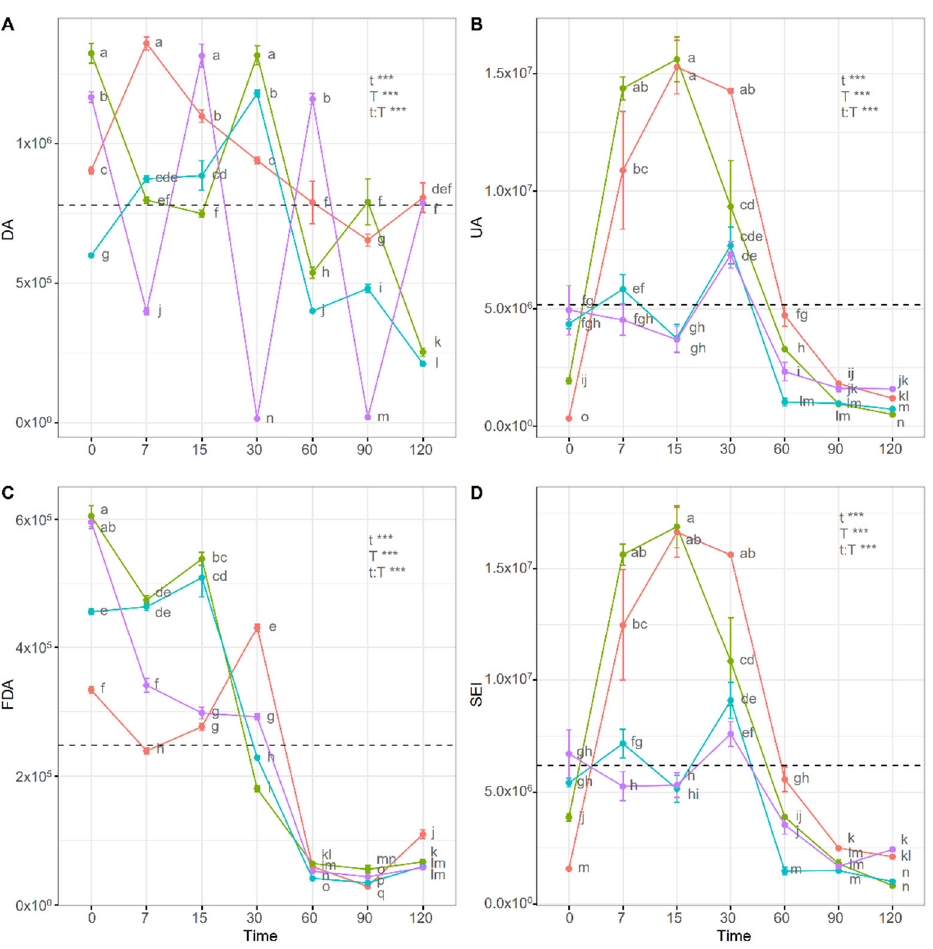
Figure 2. Two-way ANOVA of enzyme indicators of composting systems. Different letters indicate significant differences according to the two-way ANOVA with subsequent Tukey’s test for means at a significance level p ≤ 0.05. Vertical bars represent the standard deviation ( n = 5). ( A ) DA, dehydrogenase activity (nmol INTF kg − 1 compost h − 1 ); ( B ) UA, urease activity (nmol N-NH 4+ kg − 1 compost h − 1 ); ( C ) FDA, fluorescein diacetate (nmol fluorescein kg − 1 compost h − 1 ); ( D ) SEI, synthetic enzyme index (nmol kg − 1 compost h − 1 ). Dotted line represents the mean of the indicator; ***, highly significant ( p ≤ 0.001 )